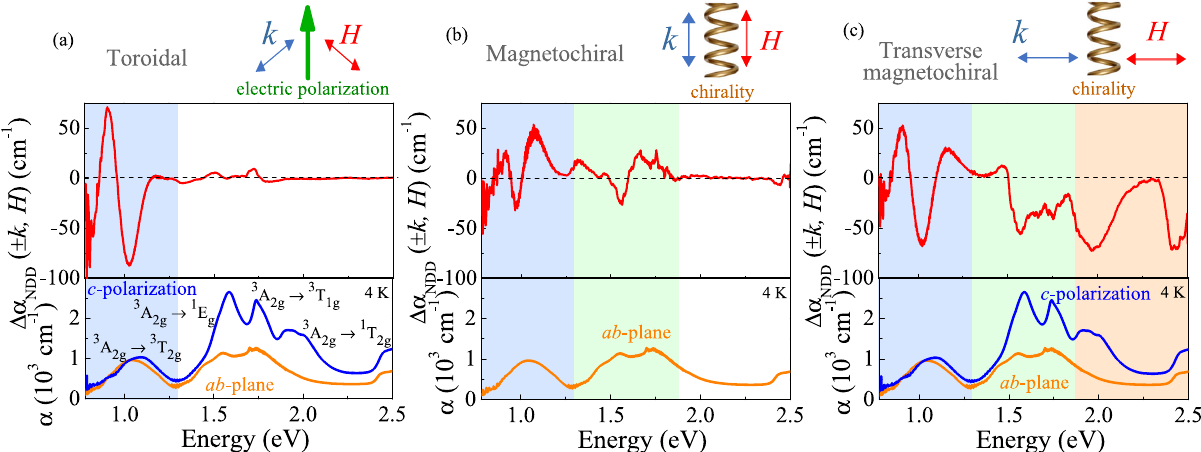
Fig. 2 Nonreciprocity of Ni 3 TeO 6 in the three different measurement con fi gurations. Summary of the three different measurement con fi gurations of interest in this work: a toroidal ( k ⊥ H ⊥ polarization, b magnetochiral ( k ∥ H ∥ chirality), and c transverse magnetochiral ( k ∥ H ⊥ chirality). Nonreciprocal directional dichroism spectra of Ni 3 TeO 6 at 60 T in the toroidal ( a ), magnetochiral ( b ), and transverse magnetochiral ( c ) con fi gurations, respectively. These spectra were measured in the Voigt ( a ) and Faraday ( b , c ) geometries. The nonreciprocal responses in panels ( b , c ) are reproduced from ref. 20 . The linear absorption spectrum of Ni 3 TeO 6 at 4.2 K is shown below each nonreciprocal panel for comparison. The polarization directions and on-site Ni d -to- d excitations are